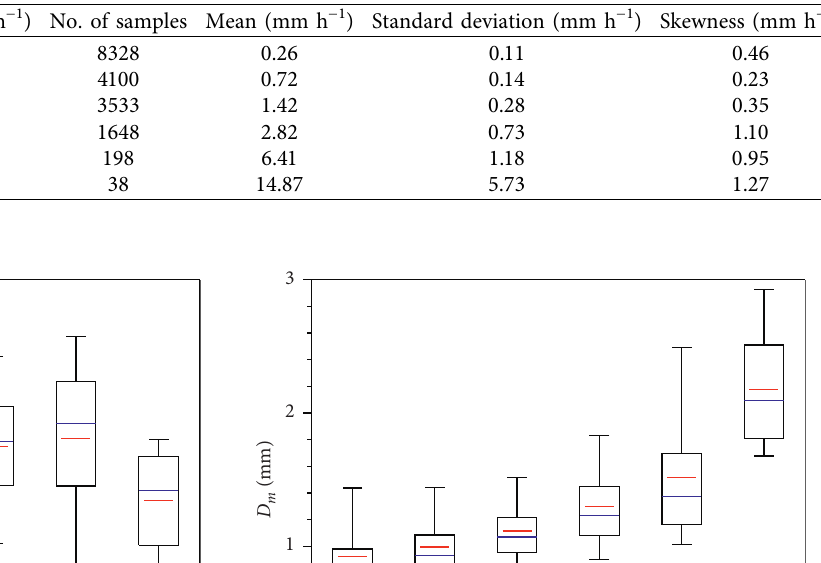
Table 3: Number and DSD retrieved rain rate statistics of each rain rate class.